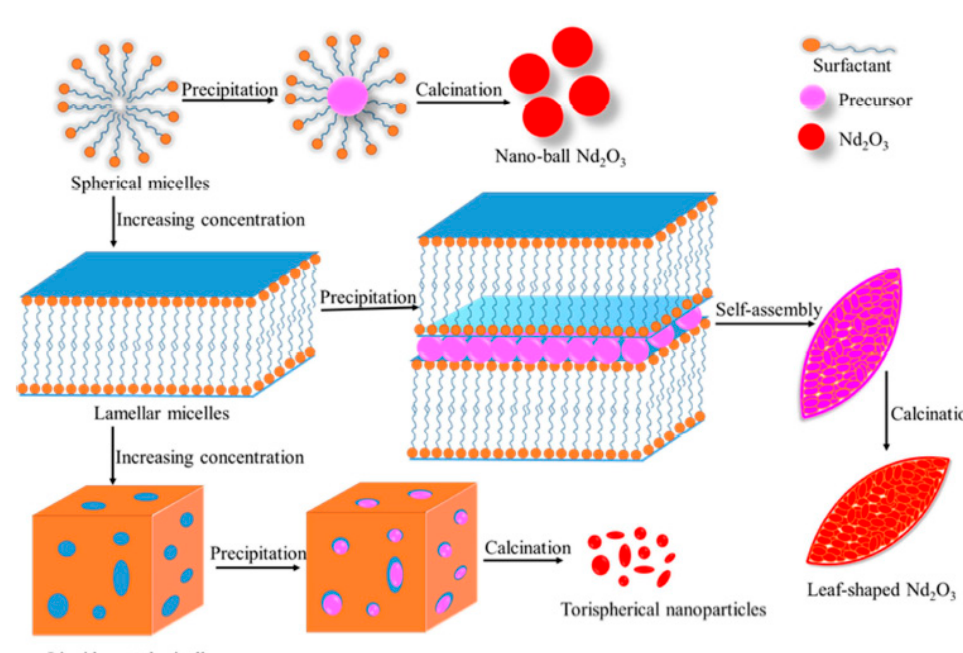
Figure 16. Schematic representation of the effects of surfactant concentrations on the morphologies of Nd 2 O 3 nanoparticles. Close to the surfactant critical micelle concentration, small, spherical micelles are formed, leading after calcination, to spherical Nd 2 O 3 nanoparticles. Micellar morphology changes at higher [surfactant] lead to the formation of leaf-shaped Nd 2 O 3 nanoparticles [204]. Reprinted with permission from ref. [204]. Copright 2021 Elsevier.